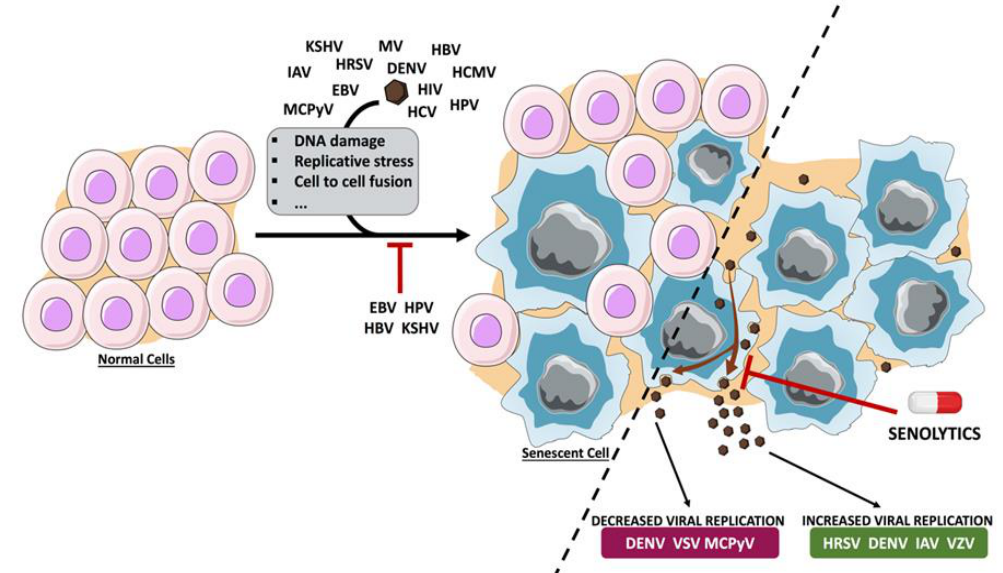
Figure 1. Schematic representation of the induction and/or inhibition of senescence by viruses and the effect of senescence on virus replication. Upon virus infection, cells can enter into senescence as a consequence of DNA damage, replicative stress or cell-to-cell fusion, among others. Cellular senescence limits the replication of different viral agents, whereas it contributes to the efficient replication of others. Consequently, targeting the senescent cells using senolytic agents has a negative or positive effect on virus infection, depending on the virus. Dengue virus (DENV), Epstein–Barr virus (EBV), hepatitis B virus (HBV), human cytomegalovirus (HCMV), human immunodeficiency virus (HIV), human papillomavirus (HPV), human respiratory syncytial virus (HRSV), influenza A virus (IAV), Kaposi’s sarcoma-associated herpesvirus (KSHV), Merkel cell polyomavirus (MCPyV), measles virus (MV), varicella-zoster virus (VZV), vesicular stomatitis virus (VSV).